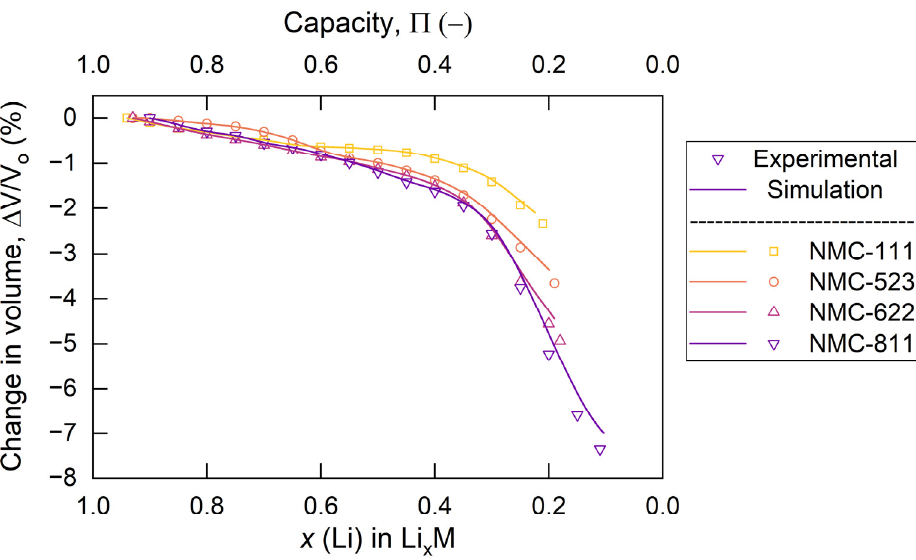
Figure 3. Local and global volume changes obtained by experiments (Adapted with permission from Ref. [52]. Copyright 2017, American Chemical Society.) and finite element simulations, respectively. The local volume change is plotted against the lithium content, and the global volume change is plotted against the normalized capacity of the various NMC materials.